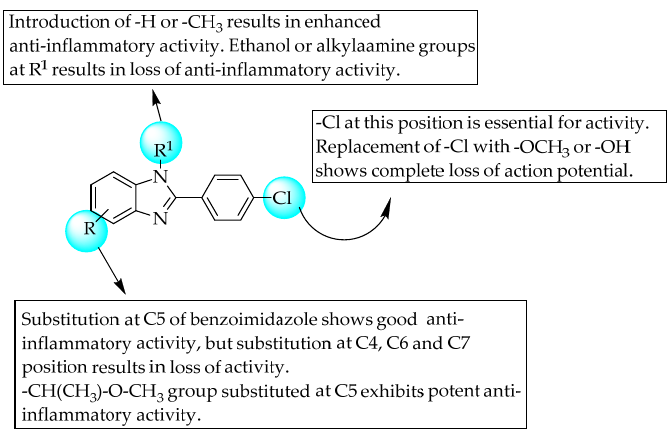
Figure 33 . SARs of 4- or 5-position-substituted benzimidazoles.